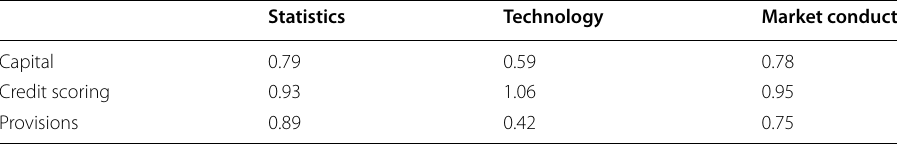
Table 8 Average number of negative terms in the 10 words surrounding the key terms